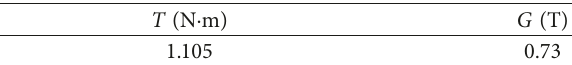
Table 4: Average value of performance index.